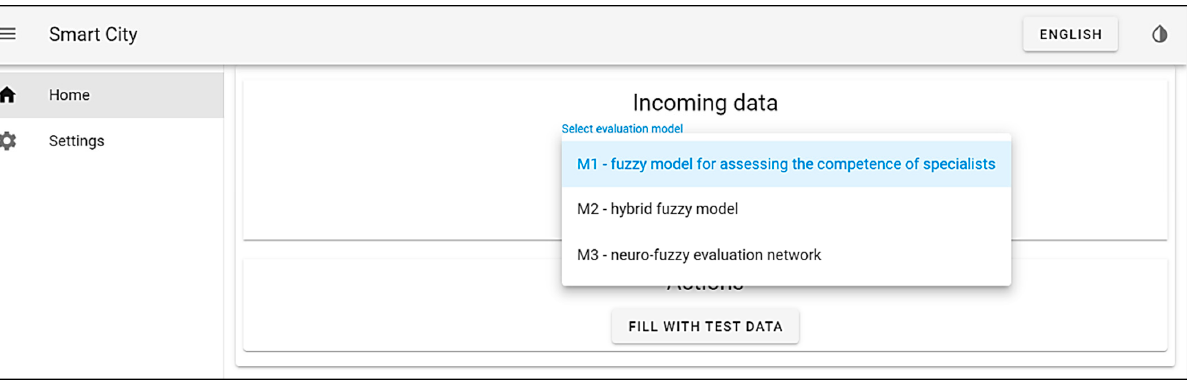
Figure 6. Head screen of the Smart City Concept Personnel Selection web platform.